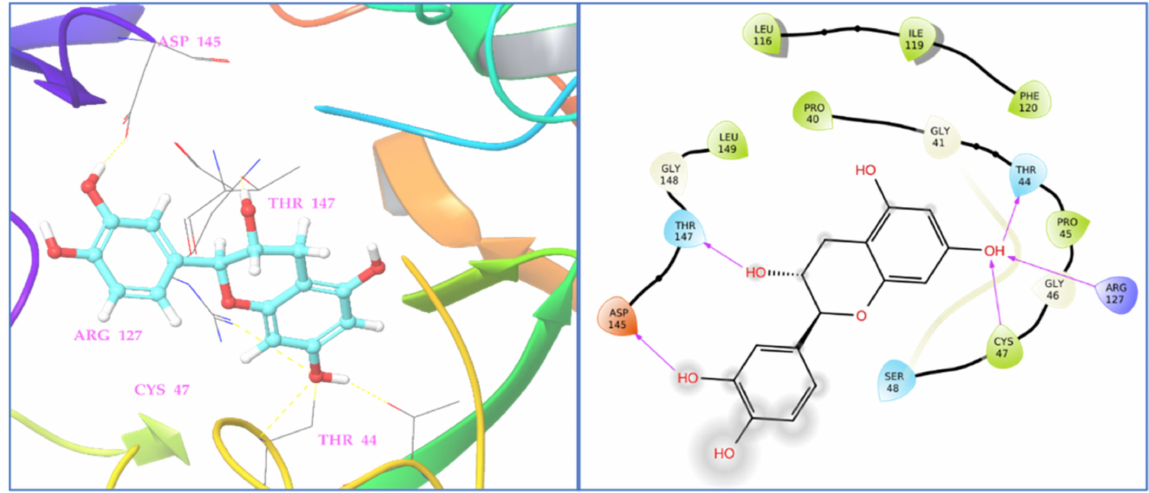
Figure 5. Two- and three-dimensional residual interactions network of ( − )-epicatechin in human peroxiredoxin 5 protein (PDB ID: